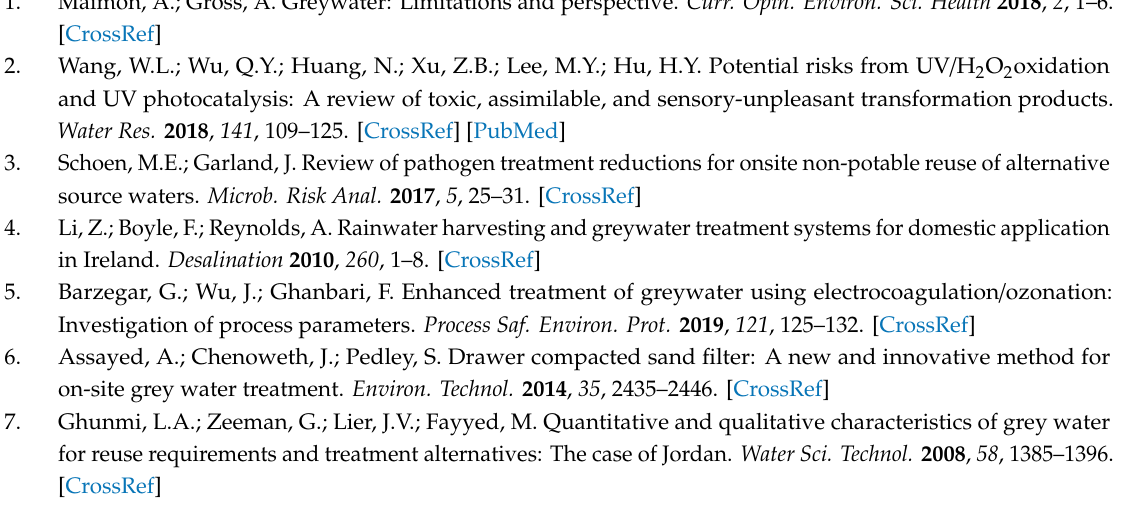
Figure S1a: Photo of the steel stirred tank reactor (STR) used in this study, Figure S1b: Photo of the borosilicate glass plate coated with TiO 2 , Figure S2a: Measured spectral output for Philips Actinic BL TL 11W / 10, Figure S2b: Spectral output for Philips MASTER PL-S 11W / 840 / 4P 1CT. Figure S3: E ff ect of TiO 2 loading and residence time on TOC reduction of GW, Figure S4: TOC reduction by ozonation and catalytic ozonation, examined with di ff erent ozone flowrate (0–41.7 mg O 3 / min) and a range of catalyst loading (0–1.98 mg TiO 2 / cm 2 ), Figure S5: TOC reduction by Ozone photolysis and photocatalytic ozonation, examined with di ff erent ozone flowrate (0–41.7 mg O 3 / min) and a range of catalyst loading (0–1.98 mg TiO 2 / cm 2 ), Figure S6: TOC reduction by H 2 O 2 / TiO 2 in dark conditions as a function of H 2 O 2 / TiO 2 molar ratio and TiO 2 loading, Figure S7: TOC reduction by H 2 O 2 / TiO 2 with visible light as a function of H 2 O 2 / TiO 2 molar ratio and TiO 2 loading, Figure S8: TOC reduction by H 2 O 2 / TiO 2 with UVA irradiation as a function of H 2 O 2 / TiO 2 molar ratio and TiO 2 loading, Figure S9: E ff ect of H 2 O 2 / O 3 molar ratios and TiO 2 loading on TOC reduction by peroxonation, Figure S10: E ff ect of H 2 O 2 / O 3 molar ratios and TiO 2 loading on TOC reduction by catalytic peroxonation, Figure S11: E ff ect of H 2 O 2 / O 3 molar ratios and TiO 2 loading on TOC reduction by UVA-peroxonation, Figure S12: E ff ect of H 2 O 2 / O 3 molar ratios and TiO 2 loading on TOC reduction by photocatalytic